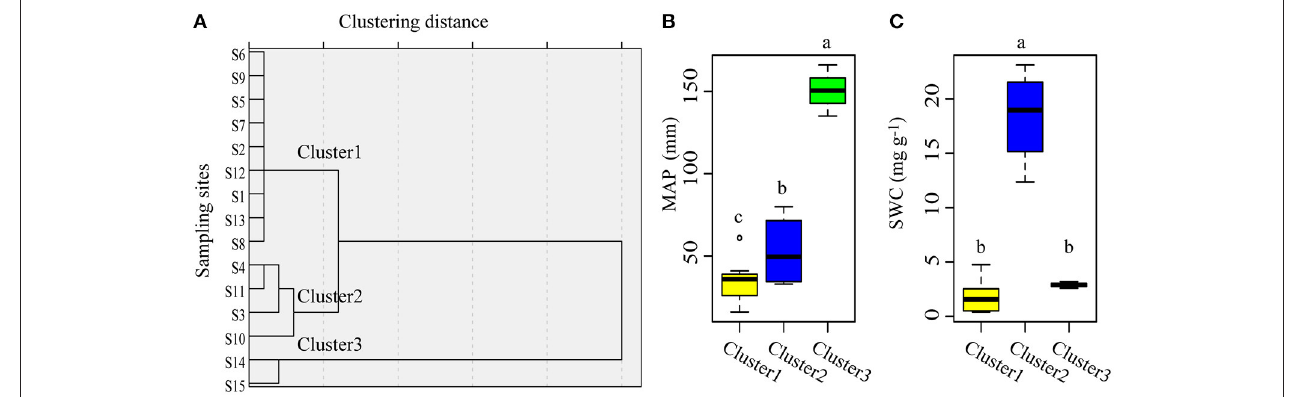
FIGURE 4 | The 15 sampling sites can be classified into three clusters based on their mean annual precipitation and mean soil water content. (A) Clustering results of the sampling sites. (B) Differences in mean annual precipitation among the three clusters. (C) Differences in mean soil water content among the three clusters. S1–S15 denotes sampling sites